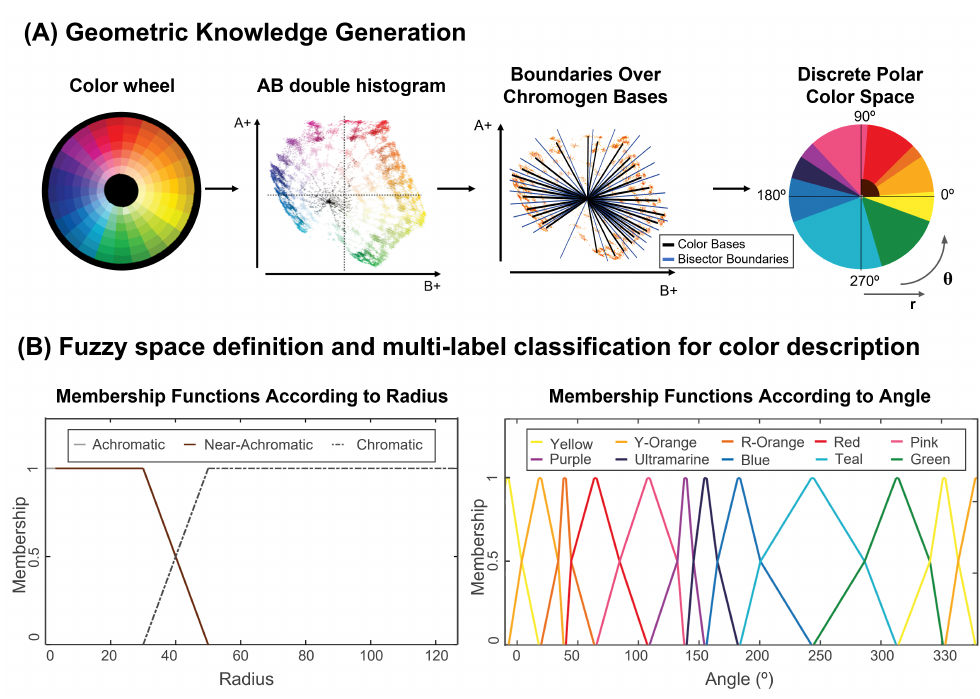
Figure 2. The two main steps of ABANICCO: ( A ) geometric knowledge generation; we used color theory to identify in the color wheel the localization of the different pure hues, shades, and tints within the reduced AB space of CIELAB; applying geometry, we used bisectors as the best boundaries between pure hues; by these means, we obtained a discrete polar color space divided into 12 different color categories—Pink, Red, Red-Orange, Yellow-Orange, Yellow, Green, Teal, Blue, Ultramarine, Purple, Brown, and Achromatic; the first 10 categories described hue, depending on the angle; the last two described chromaticity, and depended on the radius; ( B ) fuzzy space definition and multi-label classification for color description; we formalized fuzzy rules to translate the obtained discrete color polar space back into a continuous space that better mirrored human linguistics; based on the bisectors employed for the discretization of the space, we were able to define areas of absolute chromogen certainty and gradients of membership to the adjacent colors on both sides, which was done for both the radius (accounting for chromaticity) and the angle (accounting for hue); finally, with color theory, fuzzy membership functions, and multi-label classification, we assigned multiple, non-exclusive labels to each detected color, for accurate naming and